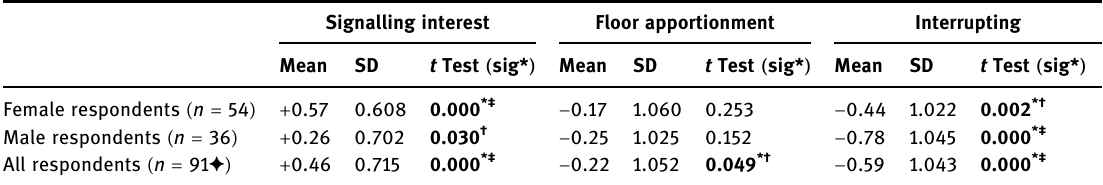
Table 3: Respondents ’ habitual associations regarding conversational behaviour. Negative values indicate “ male behaviour ” and positive values indicate “ female behaviour ”